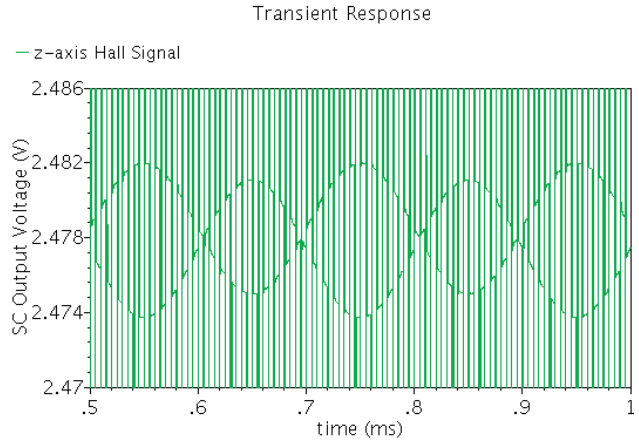
Figure 8. Transient output waveform of spinning current modulator of horizontal Hall